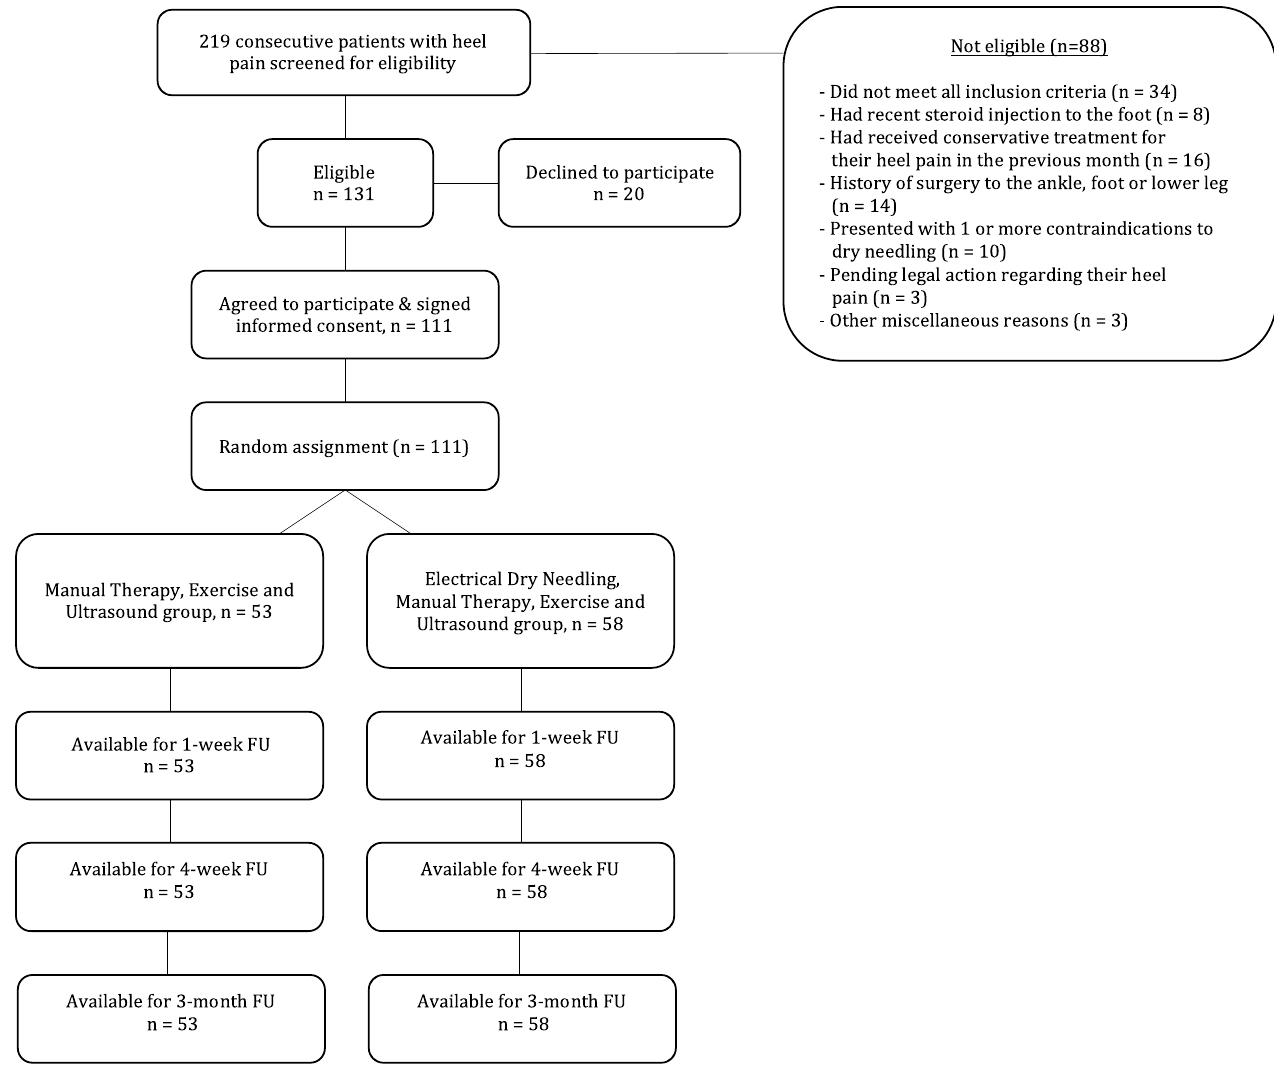
Fig 2. Flow diagram of patient recruitment and